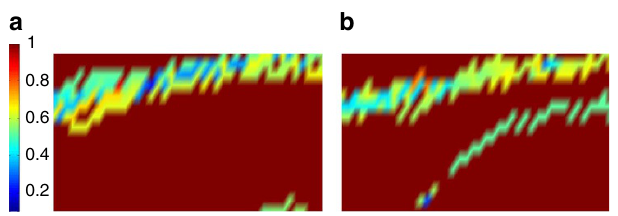
Figure 9 | Cases with multiple solutions or no solution. Colour plot of the largest weight of each gate state in the circuit for a system of size 16 (cid:4) 42 and 20% TOFFFOLI gates after a relaxation time t E 2 20 . ( a ) Case with eight solutions and ( b ) case with no solution. The learning algorithm eventually gets stuck at the point where no more gates have majority weight above the threshold a